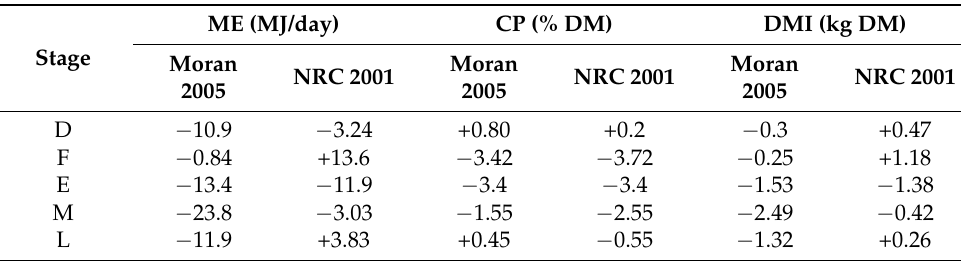
Table 6. Calculated deficit and/or excess of metabolisable energy (ME; MJ/day), crude protein (CP; % DM), and daily DM intake (DMI; kg DM) of dairy cows in the current study compared to guidelines published by NRC [29] and Moran